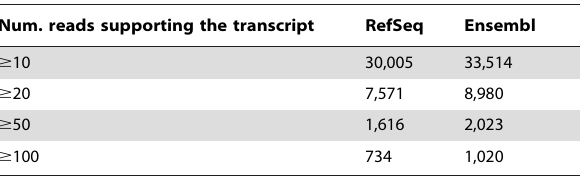
Table 3. Number of previously un-annotated transcripts reconstructed using RefSeq or Ensembl annotations as the reference.